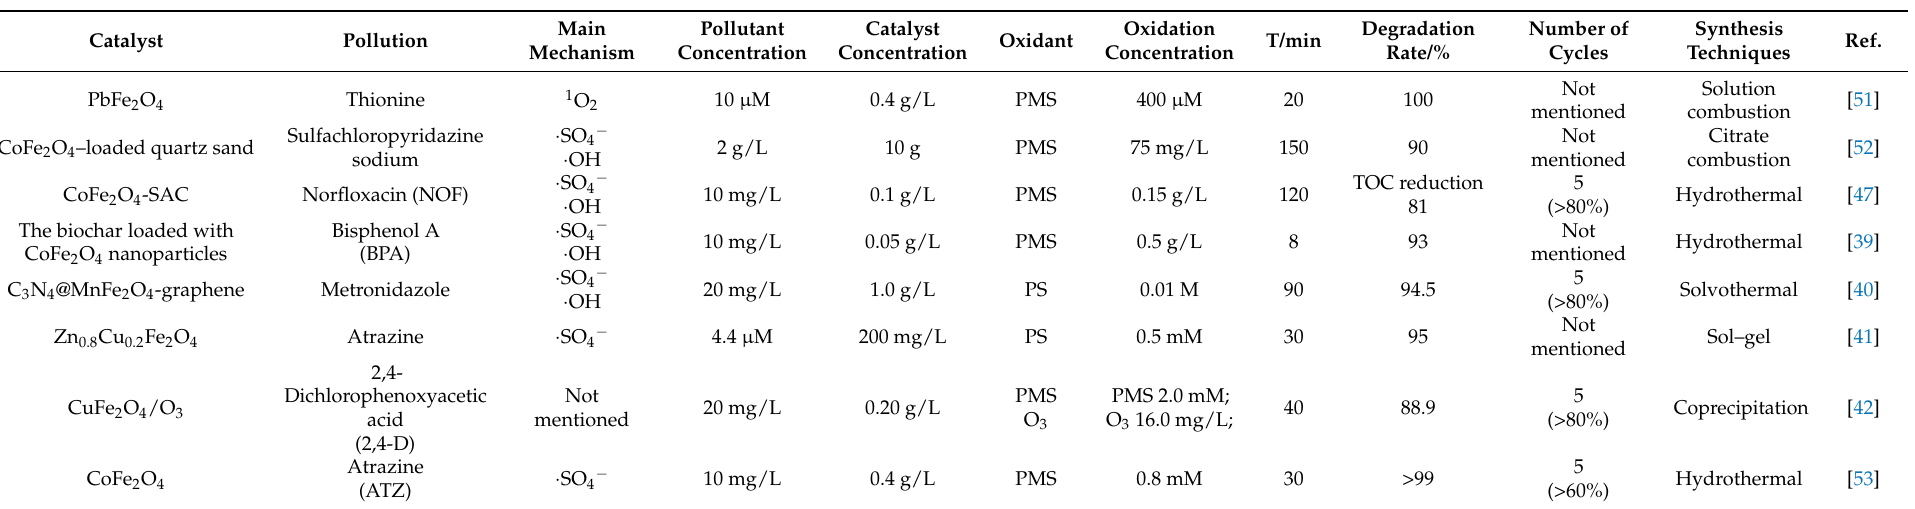
Table 1. Effect of Different MeFe 2 O 4 -activated PMS on degradation of different wastewater